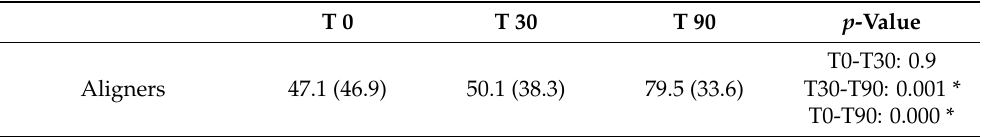
Figure 1. Box plots show median values for variables Advanced Oxidative Protein Product (AOPP), Total Antioxidant Capacity (TAC), and Myeloperoxidase Activity (MPO) during the 90-day study period (T-0, T-30, and T-90 days) for the two orthodontic techniques. Table 2. Mean AOPP values (SD) ( µ M) for the two orthodontic techniques at T 0, T 30, and T 90. * p <